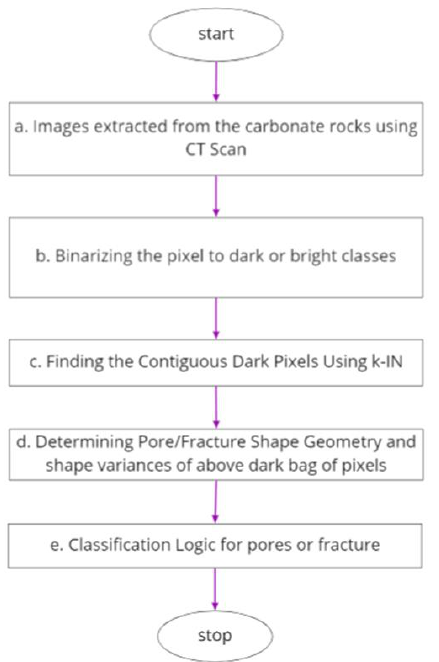
Figure 4. Overall architectural flow: ( a ) Images extracted from the carbonate rocks using CT Scan, ( b ) binarizing the pixel to dark or bright classes ( c ) find contiguous pixels using k-IN ( d ) procedure to find k -INs of any pixels as per algorithm 1 ( d ) finding shape geometry kpi’s such as area( ℋ 𝑖 ), major( ℋ 𝑖 ), minor( ℋ 𝑖 ), perimeter( ℋ 𝑖 ) and curl( ℋ 𝑖 ) of a pore and fracture and ( e ) classification into pore or fracture.